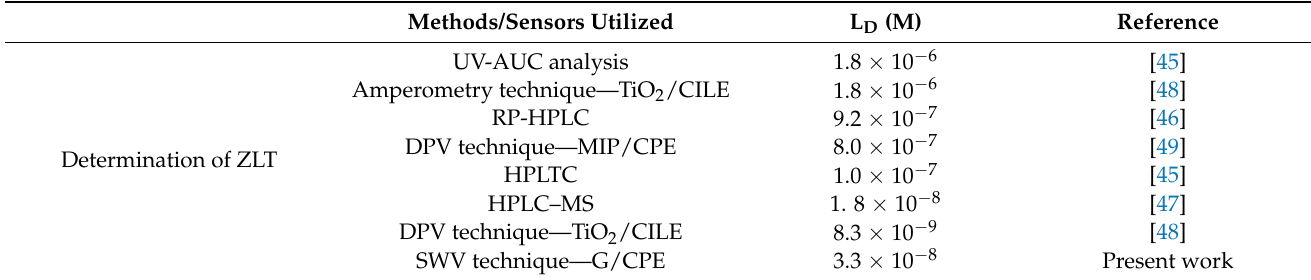
Table 1. A comparison of the proposed method with previously reported